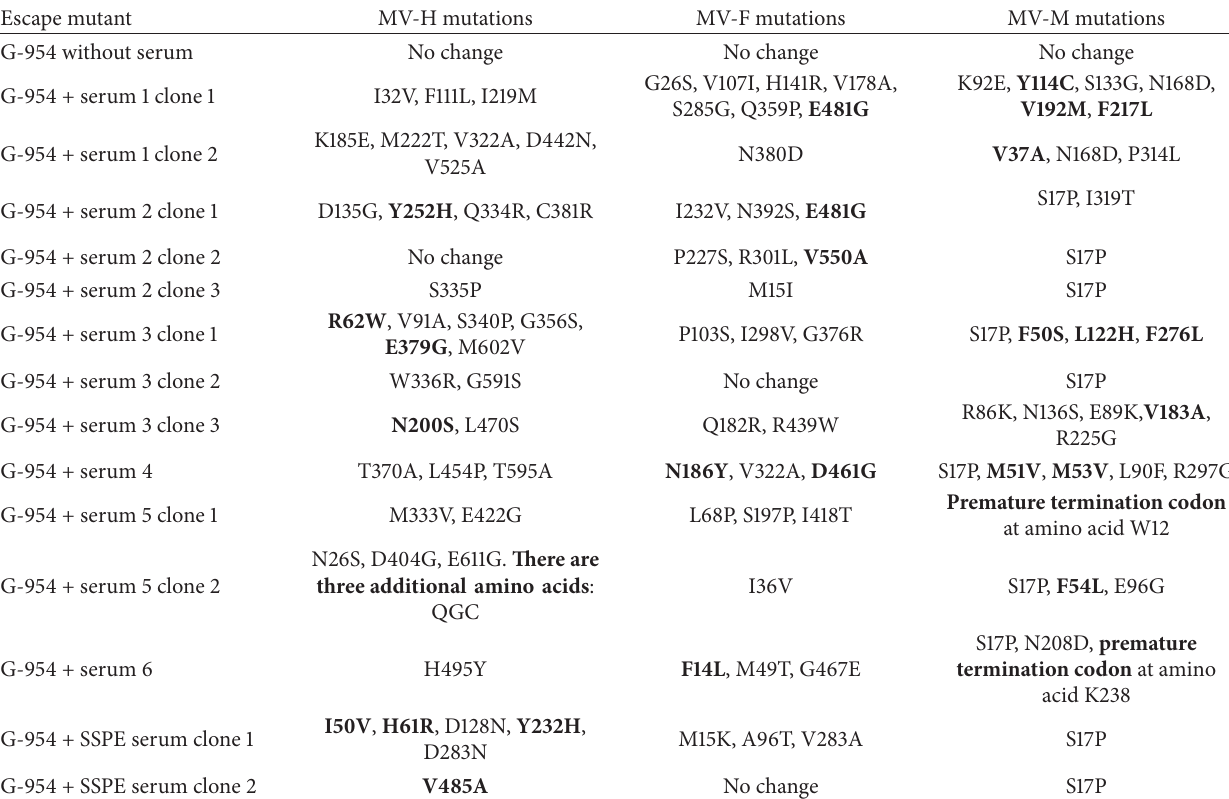
Table 1: Mutations present in the H, F, and M genes of MV-G954 escape mutants obtained by in vitro immune selection. Escape mutant MV-H mutations MV-F mutations MV-M mutations G-954 without serum No change No change No change G26S, V107I, H141R, V178A, K92E, Y114C , S133G, N168D, G-954 + serum 1 clone 1 I32V, F111L, I219M V192M , F217L S285G, Q359P, E481G K185E, M222T, V322A, D442N, G-954 + serum 1 clone 2 N380D V37A , N168D, V525A